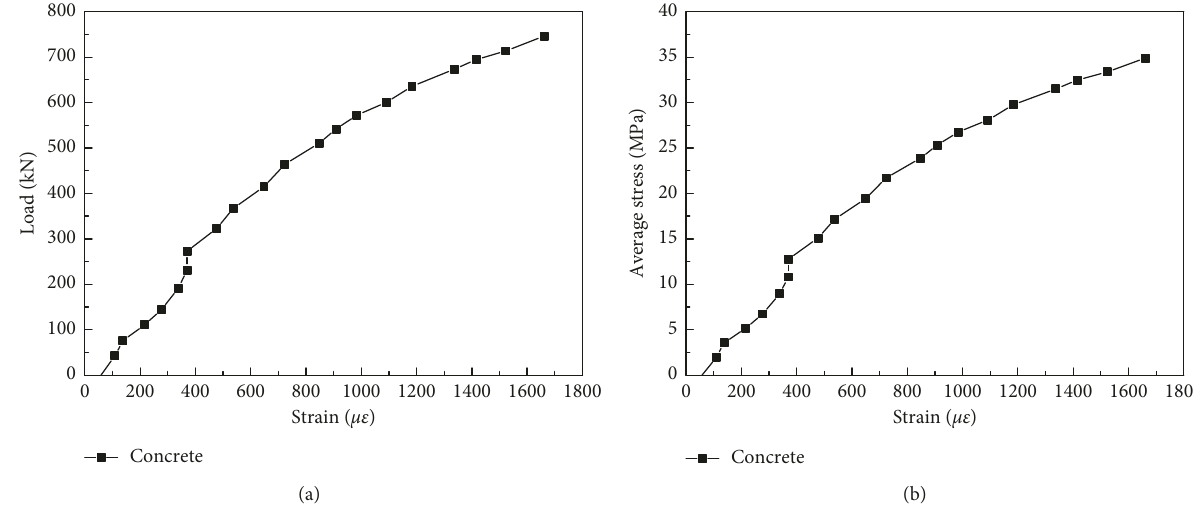
Figure 16: Axial compressive strain development of core concrete of specimen